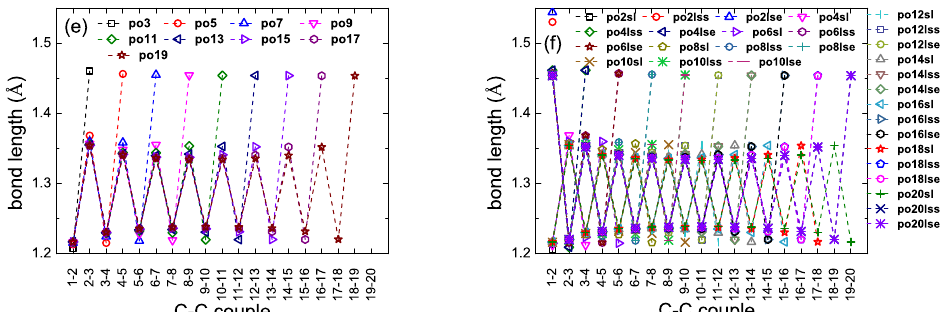
Figure 3. Bond lengths of polyynic molecules. B3LYP/6-31G* level of theory, without any constraint on the position of atoms. ( a ) N = 7, ( b ) N = 8, ( c ) N = 9, ( d ) N = 10, ( e ) N odd, ( f ) N even.